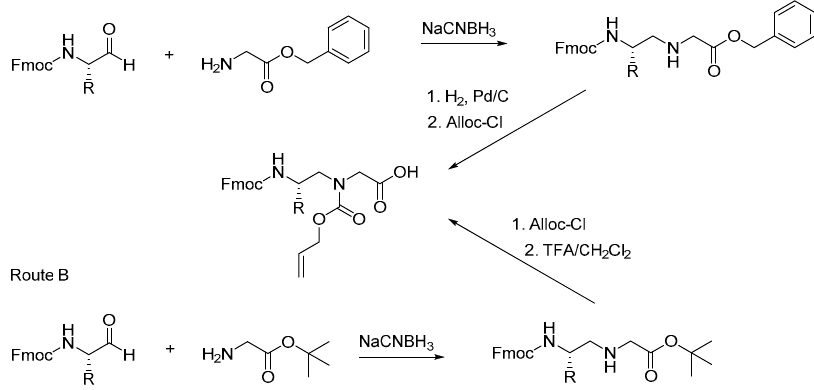
Scheme 15. Synthesis of γ -AApeptide building blocks by two different routes.